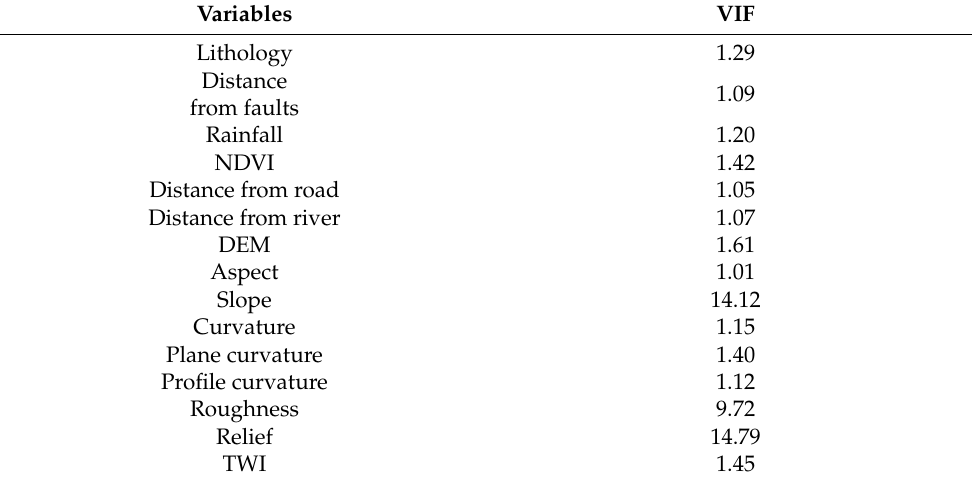
Table 6. VIF analysis results.